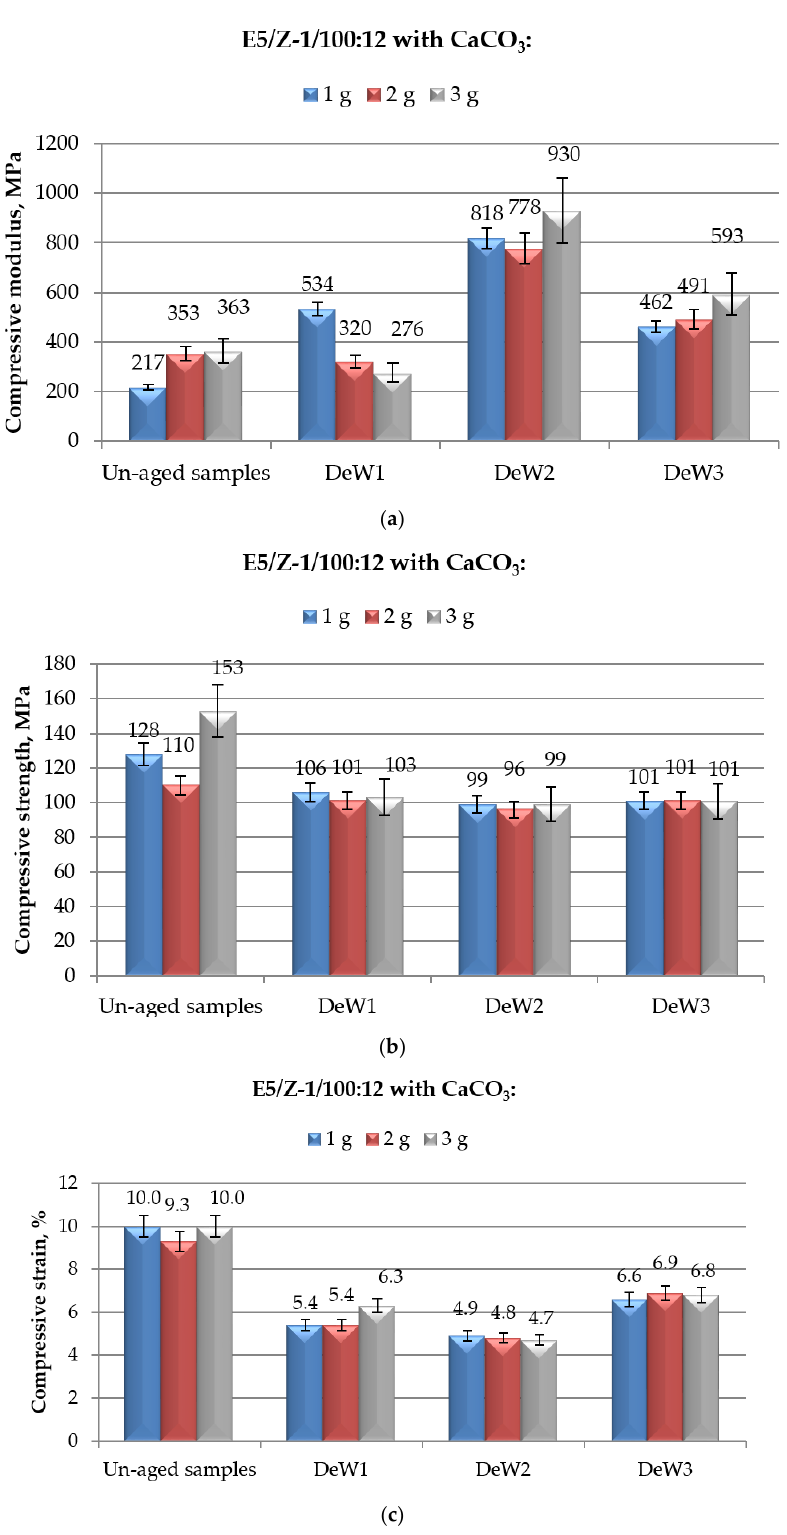
Figure 5. Results of mechanical (in compression mode) tests performed on E5/Z-1/100:12 epoxy compounds filled with different amounts of CaCO 3 and aged for different time spans (from 1 to 10 months) in demineralised water: ( a ) Compressive modulus; ( b ) compressive maximum strength; and ( c ) compressive strain at break.